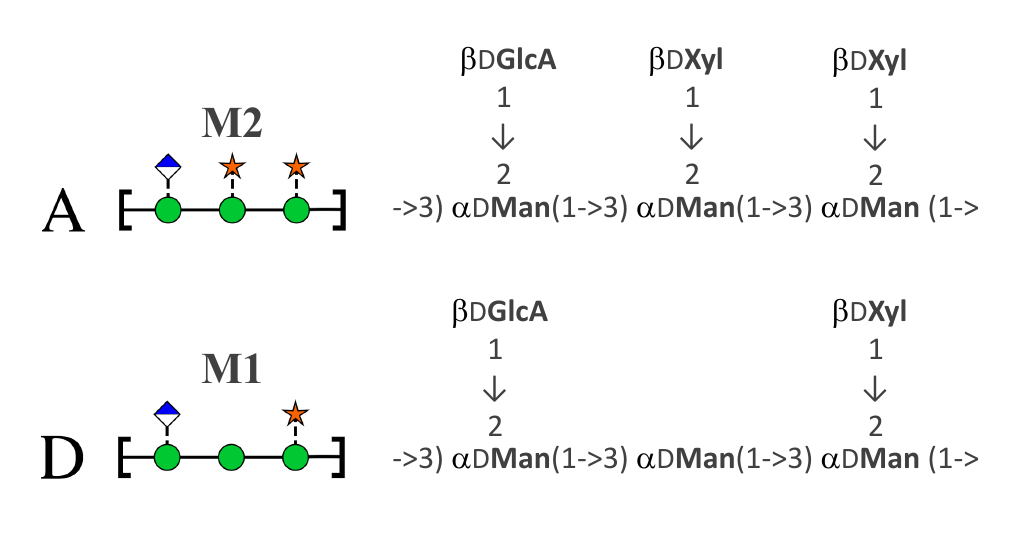
Figure 1. The predominant GXM repeat unit motif (triad) in C. neoformans serotypes. Serotype A ( Cryptococcus neoformans var. grubii , top) has predominantly the M2 triad and serotype D ( Cryptococcus neoformans var. neoformans , bottom) the M1 triad [11]. The RUs are shown on the left with the SNFG symbols